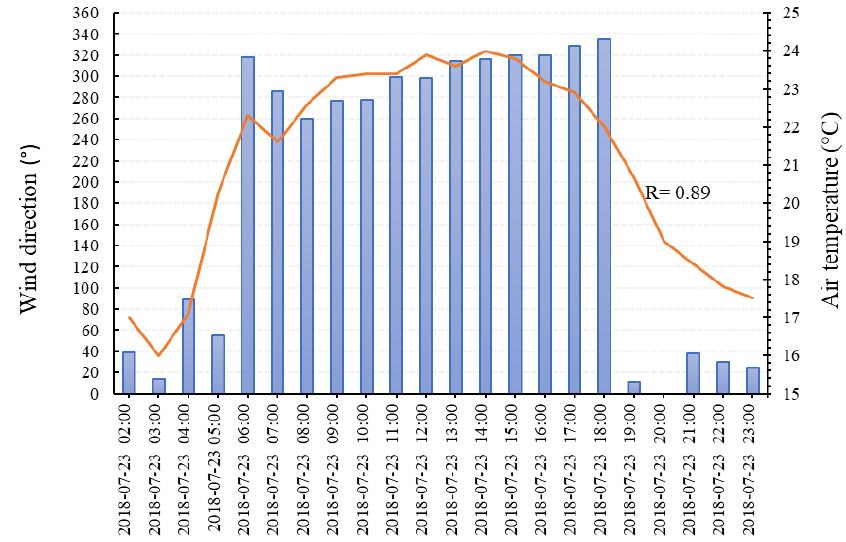
Figure 5. The predominance of the sea breeze at the southeastern Baltic Sea coast. Data from the coastal meteorological station, Klaipeda (23 July 2018). The beginning is fixed at 06:00 h, and the end of the phenomena is around 19:00 h. R (correlation coefficient) represents the relationship between the change in air temperature and wind direction during the day.